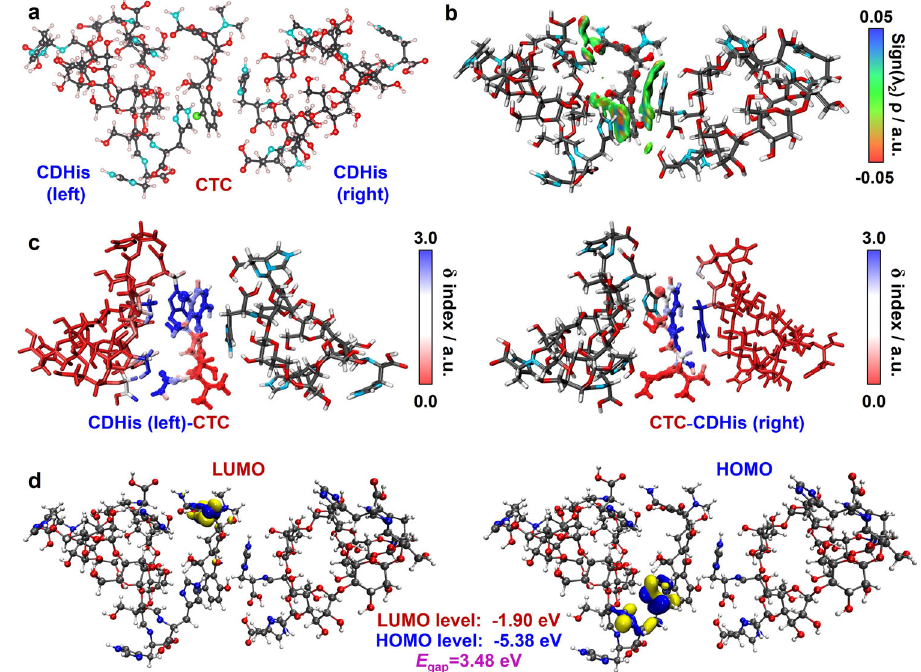
Fig.7|BindinggeometryofCDHisandCTC.a Theoptimizedbindinggeometryof the CDHis (cid:129) CTC (cid:129) CDHis complex at the B3LYP-D3/6 – 311G(d)/SMD(water) level of theory. b Independent gradient model (IGM) analysis of CDHis (cid:129) CTC (cid:129) CDHis com- plex. δ g inter =0.01a.u.isosurfacescoloredbythesignof( λ 2 ) ρ fortheCDHisandCTC complex. The red indicates strong attraction, while the blue indicates strong